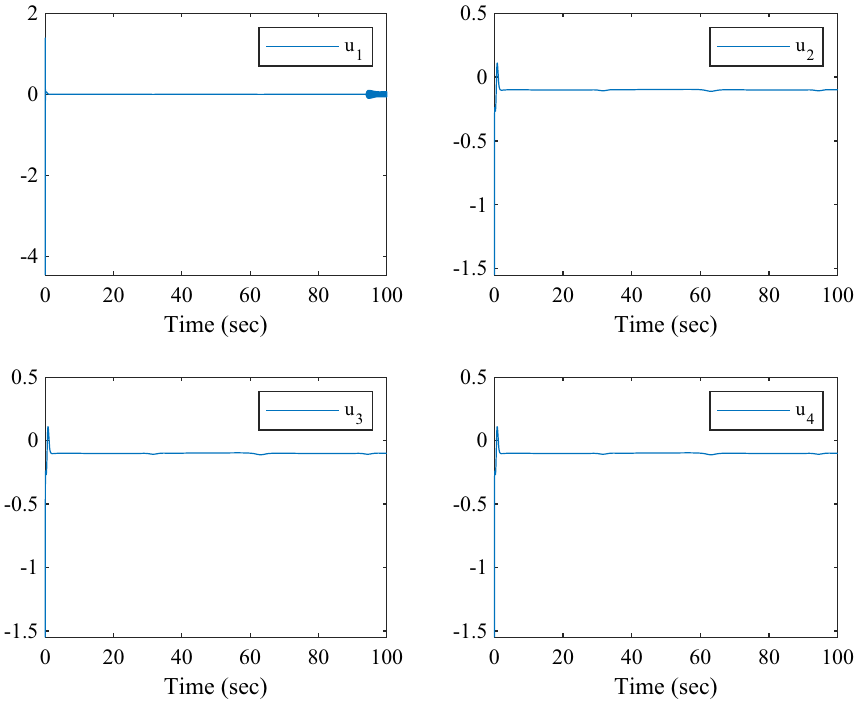
Figure 9. Distributed adaptive neural networks control laws of the multiagent